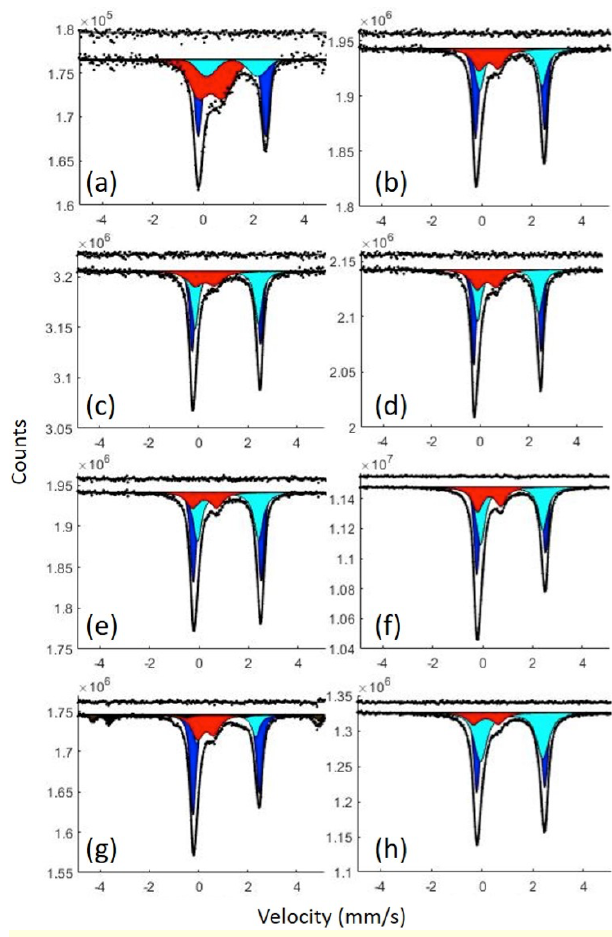
Figure 2. Room temperature Mössbauer spectra of serpentines and chlorites: (a) BCS32, (b) BCS16A, (c) ¯Oeyama, (d) ET5, (e) Viso4 matrix, (f) Viso4 vein, (g) ZS24 and (h) BCS6F. All spectra were fit with two doublets assigned to Fe 2 + (dark blue and light blue) and one doublet assigned to Fe 3 + (red). The spectrum from chlorite ZS24 (g) was additionally fit to two sextets assigned to magnetite (black) that were constrained based on a spectrum collected of the same sample at ± 12mms − 1